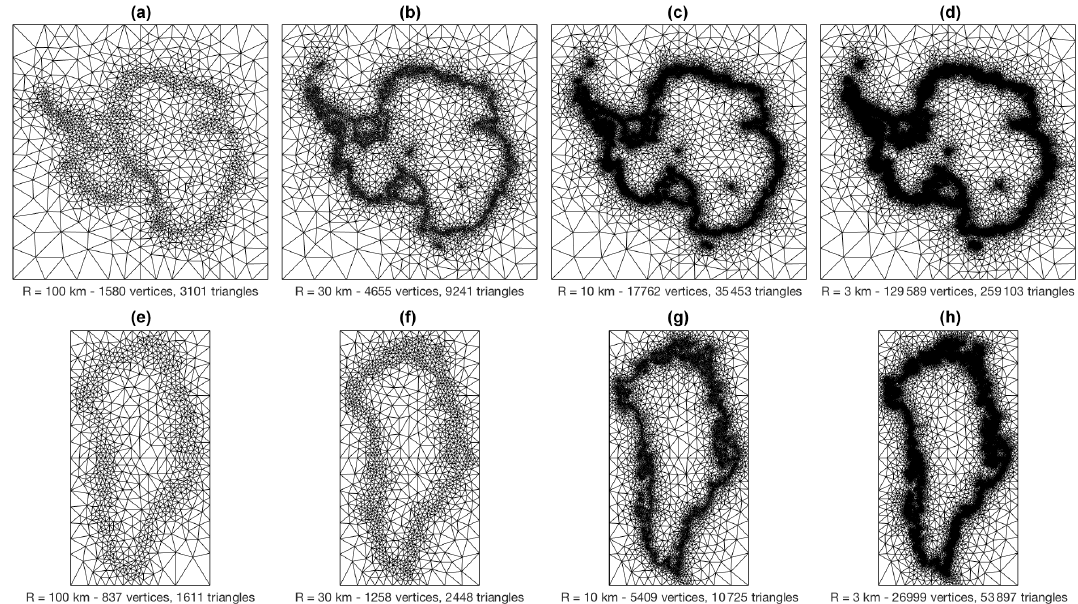
Figure 1. Meshes generated for Antarctica (a–d) and Greenland (e–h) , based on present-day ice-sheet geometry, with maximum ice-margin (including grounding line and calving front) resolutions of 100, 30, 10, and 3km, respectively. For Antarctica, two high-resolution locations are included: one at the South Pole, and one at the EPICA Dome C drill site. Both have been prescribed the same resolution as the ice